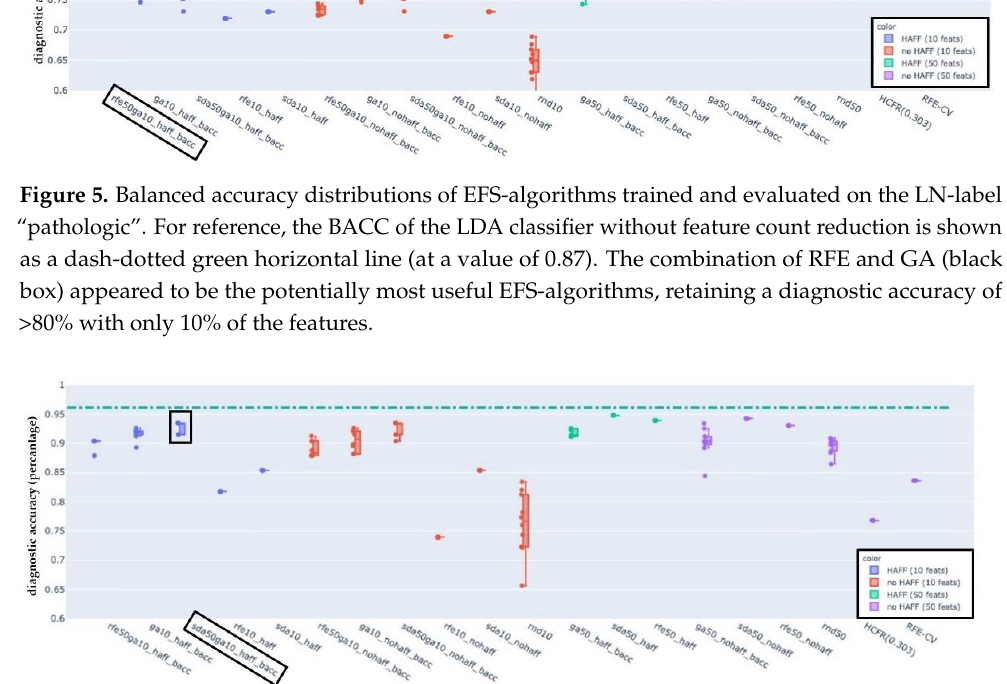
Figure 6. Balanced accuracy distributions of EFS-algorithms trained and evaluated on the LN-label “pathologic with ECS”. For reference, the BACC of the LDA classifier without feature count reduction is shown as a dash-dotted green horizontal line (at a value of 0.96). The combination of SDA and GA (black box) appeared to be the potentially most useful EFS-algorithms, retaining a diagnostic accuracy of >90% with only 10% of the features.